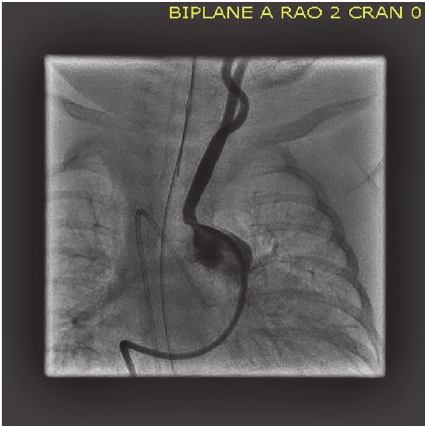
Figure 2: Camera in the AP plane. A contrast injection reveals anomalous origin of the left common carotid artery from the roof of the main pulmonary